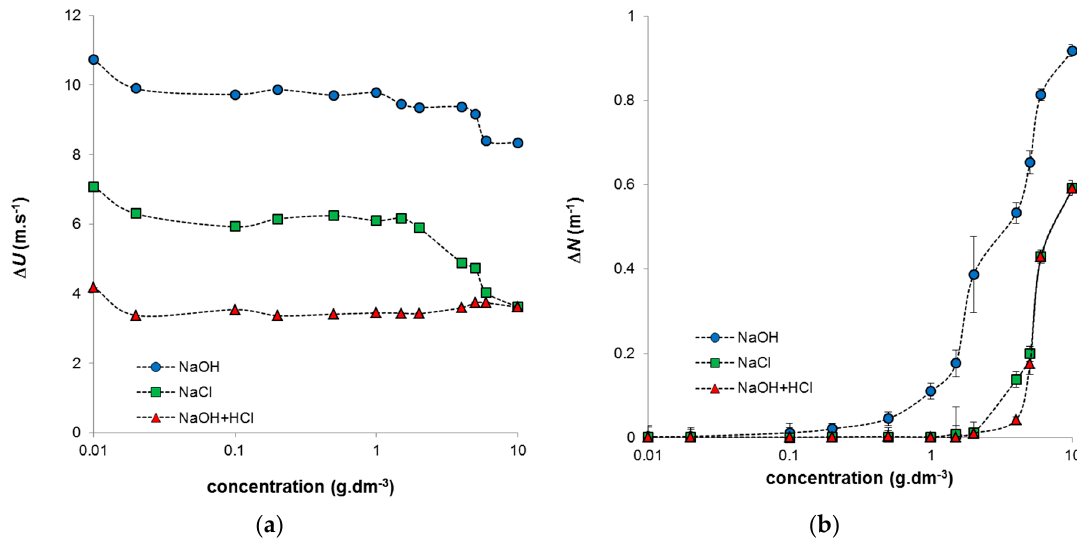
Figure 3. Obtained ultrasound parameters—velocity Δ U ( a ) and attenuation Δ N ( b ) of prepared humic sols in dependence on concentration of humic acids.